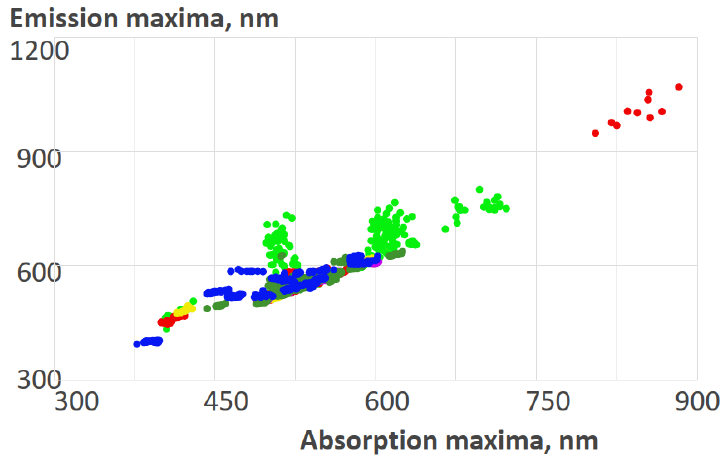
Figure 2. Absorption maxima versus emission maxima plot for a six-cluster dataset of 115 BODIPYs. For a key for the clusters, see in Schemes 1–6 and Figure